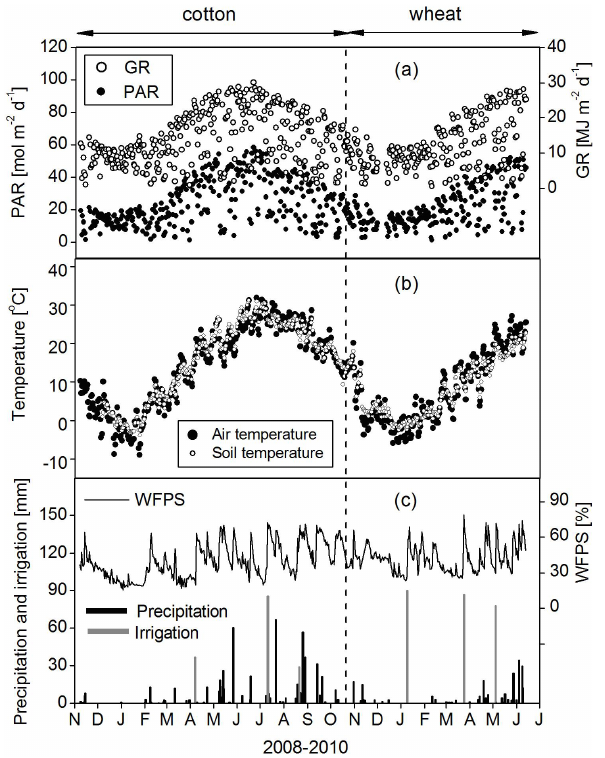
Fig. 3. (a) The daily cumulative global radiation (GR) and photo- synthesis active radiation (PAR), (b) the daily mean air temperature and soil temperature at a depth of 5cm, (c) the daily precipitation, the water amount of each irrigation event and the daily mean soil moisture (water-filled pore space, i.e. WFPS) at depths of 0–6cm during the entire measurement